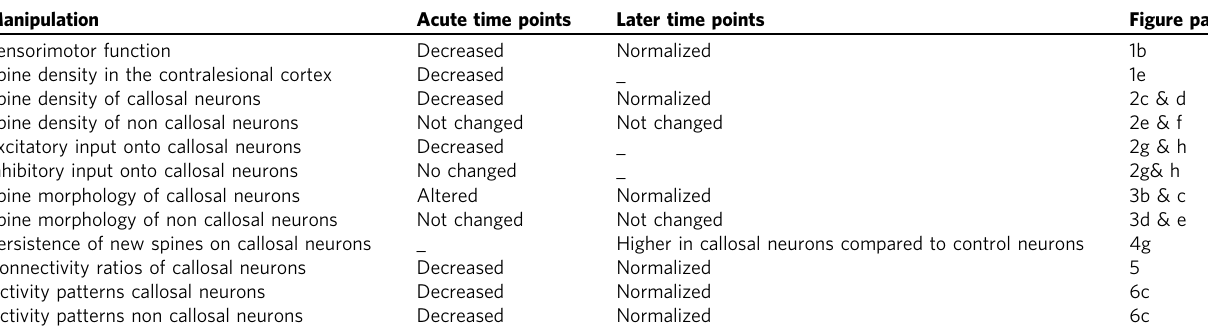
Table. 1 Summary table of the changes and adaptations of callosal neurons following contralateral traumatic brain injury.